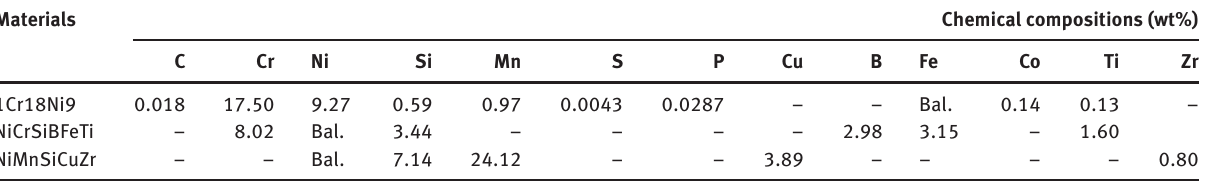
Table 1: Chemical compositions of 1Cr18Ni9 steel and brazing filler metals.